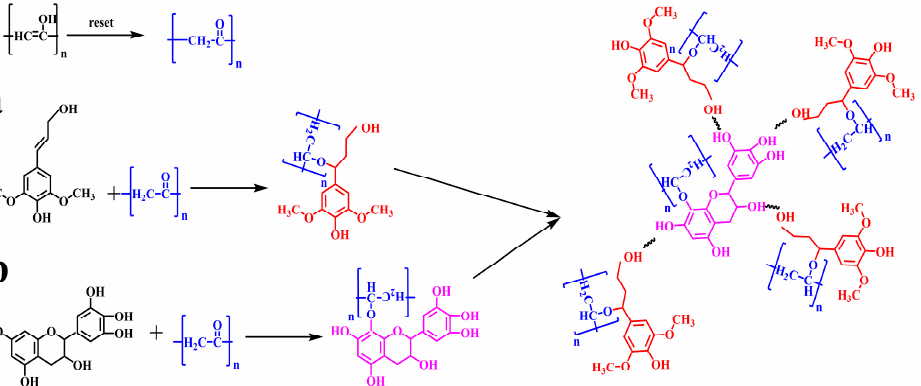
Scheme 2. Main chemical reactions of lignin, tannin and PVOH, ( a ) the reaction between lignin and PVOH, ( b ) the reaction between tannin and PVOH.